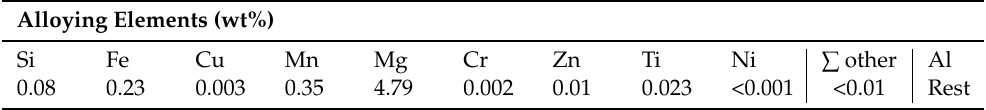
Figure 2. Schematic experimental setup with applied thermo-couples and tool dimensions of hollow cylinders. Table 1. Chemical composition of the AA5182 material used for this study as determined by spectral analysis